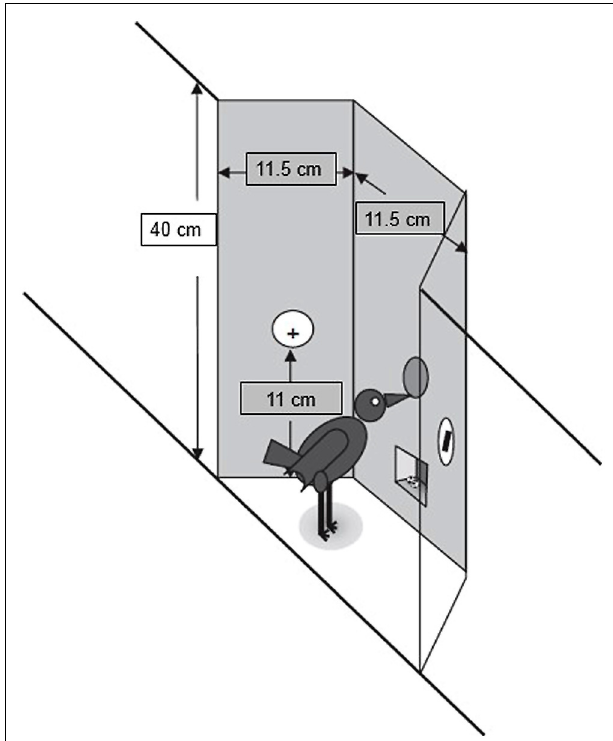
FIGURE 2 | Schematic representation of the experimental panel used in the experiments. Adapted with permission from Shapiro etal. (2008).